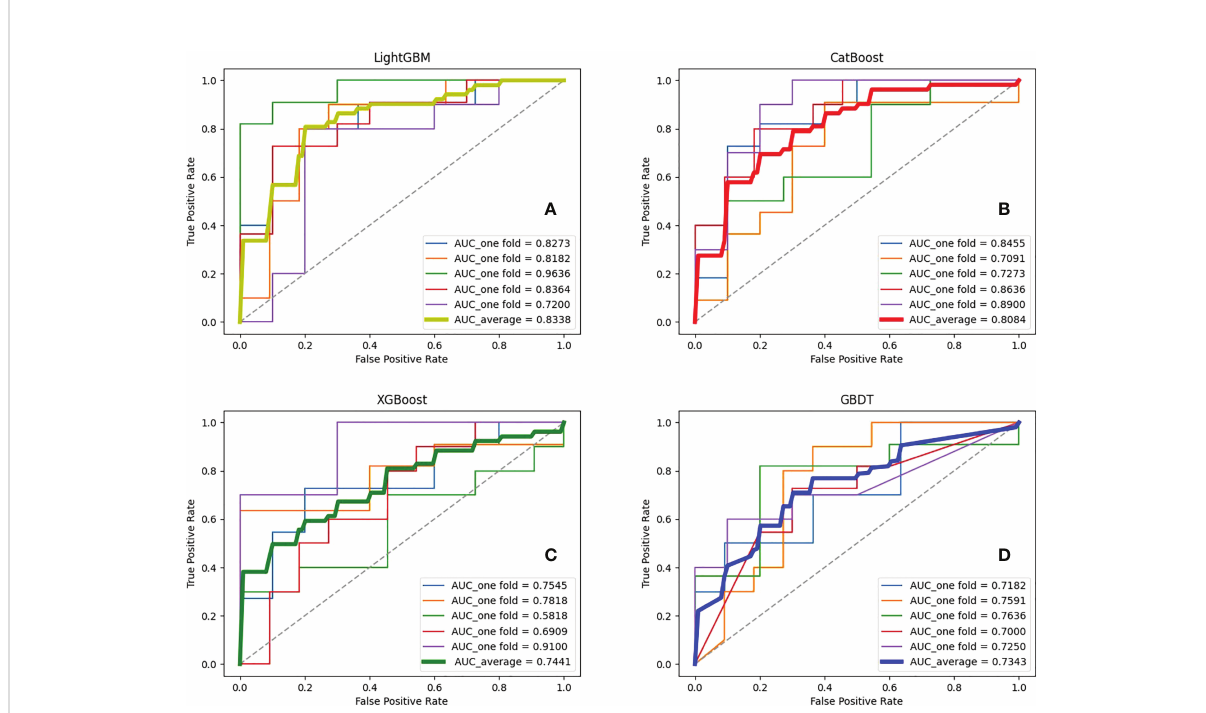
FIGURE 7 ROC curves and corresponding AUCs of various ensemble learning models. (A – D) represent the results of ensemble learning models - Light Gradient Boosting Machine (LightGBM), Categorical Boosting (CatBoost), eXtreme Gradient Boosting (XGBoost) and Gradient Boosting Decision Tree (GBDT),